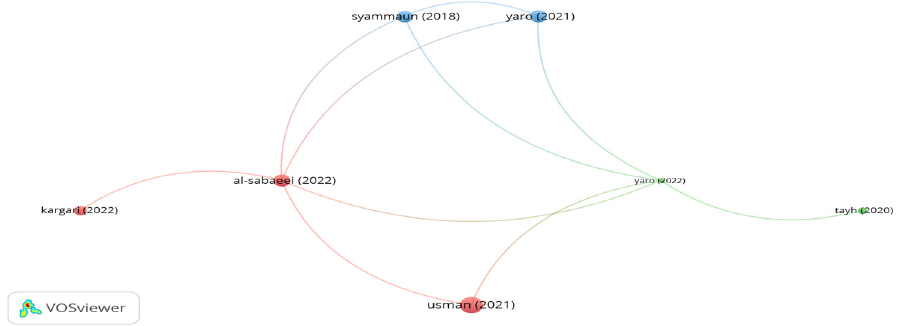
Figure 13. Network visualization of palm